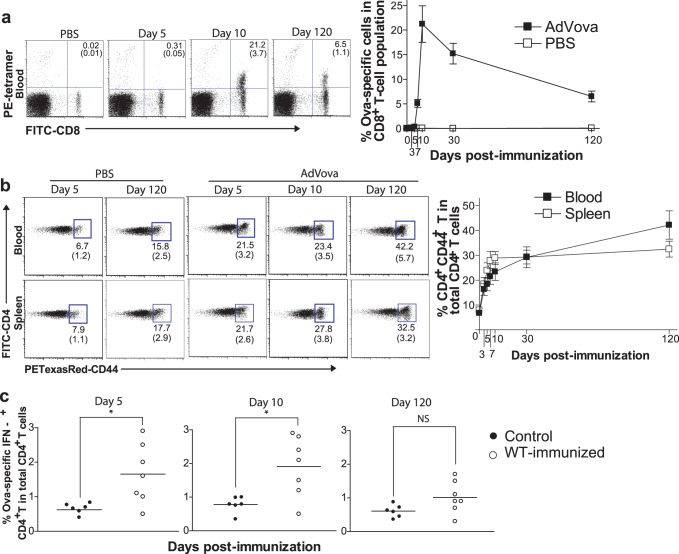
AdVova stimulates persistent CD4+ and CD8+ T cell responses.Following immunization, the AdVova-specific CTLs (a) and CD44+CD4+ T cells (b) in the peripheral blood and/or spleens were analyzed by flow cytometry at the indicated time points after tetramer staining, and CD44 and CD4 double marker staining, respectively. The values in the figure (left panel) or line diagram (right panel) are presented as mean%±SD of OVA-specific CD8+ CTLs in total CD8+ T cell population (a) or of CD44+ CD4+ T cells in total CD4+ T cell population (b), and are cumulative of three independent studies with three to five mice per group. (c) Following immunization, the spleen samples were analyzed for OVA-specific CD4+ T cells by intracellular IFN-γ staining at the indicated intervals. The values (% frequencies) are cumulative of two independent experiments with three to four mice per group. *P<0.05, versus matching controls.